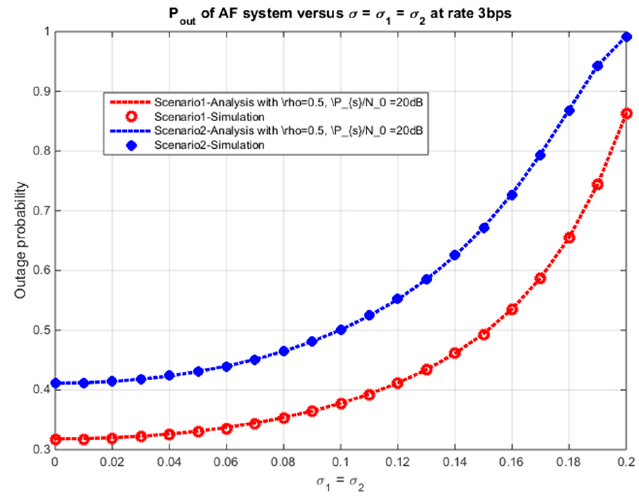
Figure 9. The outage probability versus σ 1 = σ 2 .